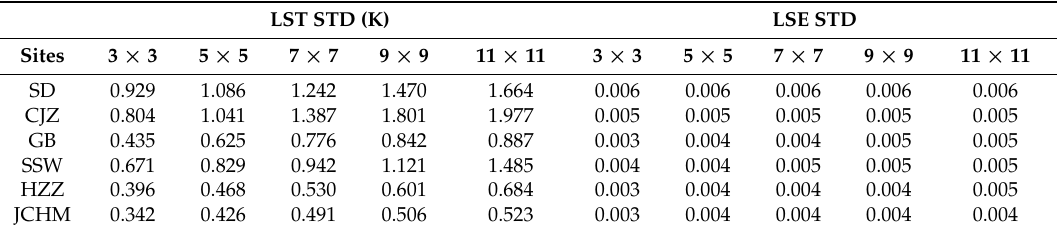
Table 5. The average STD of the 3 × 3, 5 × 5, 7 × 7, 9 × 9, and 11 × 11 pixels extracted from 20 scenes of ASTER LST or ASTER LSE products at six